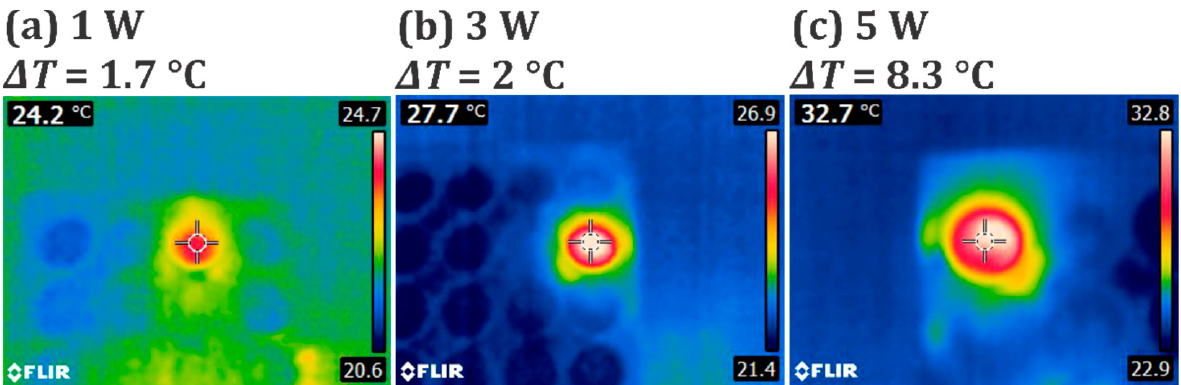
Figure 5. Thermal images of cells in 24 well plate. For each experiment, a single well was irradiated with an 808 nm laser for 10 min. Final temperatures and ∆ T values (difference in the temperature before and after irradiation) values for cells irradiated with ( a ) P = 1, ( b ) P = 3, and ( c ) P = 5 W/cm 2 are indicated. Cell viability assay and optical inspection of cells were performed 24 h post-irradiation to detect any possible delayed effect of the laser irradiation on the cells. Cell viability remained high in all cases (96 ± 2%, n = 3). To support these data, optical images are shown in Figure 6, indicating no significant morphological changes compared to a control sample. Therefore, to prevent the non-selective heating of the cells, the intermediate laser